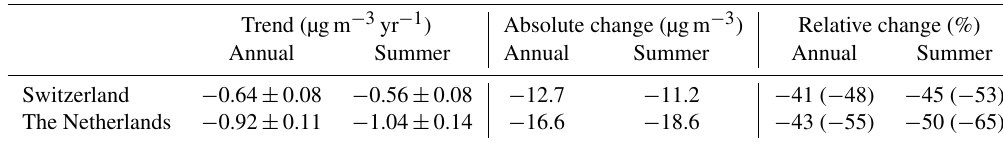
Table 2. Trends (and their standard errors) and total changes in PM 10 concentrations measured at three stations in Switzerland (1990–2010) and at three stations in the Netherlands (1992–2010). The total relative changes in the estimated PM 2 . 5 concentrations are also reported in parentheses. All trends are statistically significant (at the 99% confidence level).